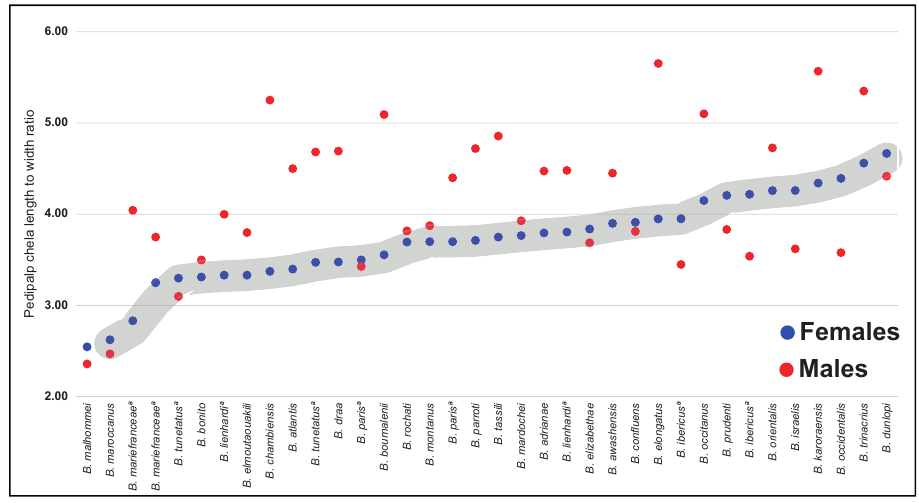
Figure 11. Graphical representation of the relation between female and male pedipalp chela aspect ratio in Buthus species. Only those species with available data from both sexes were plotted. The grey area represents species without perceived sexual dimorphism. Species with males above that area have slender pedipalp chela than females, while species with males plotted below have more robust pedipalp chela than